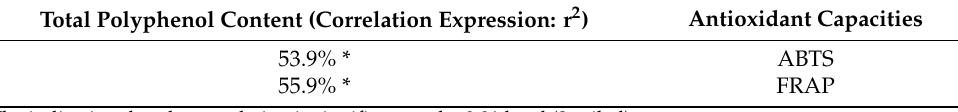
Table 3. Correlation between total polyphenol content in the samples of vegetarian sausages and measured antioxidant